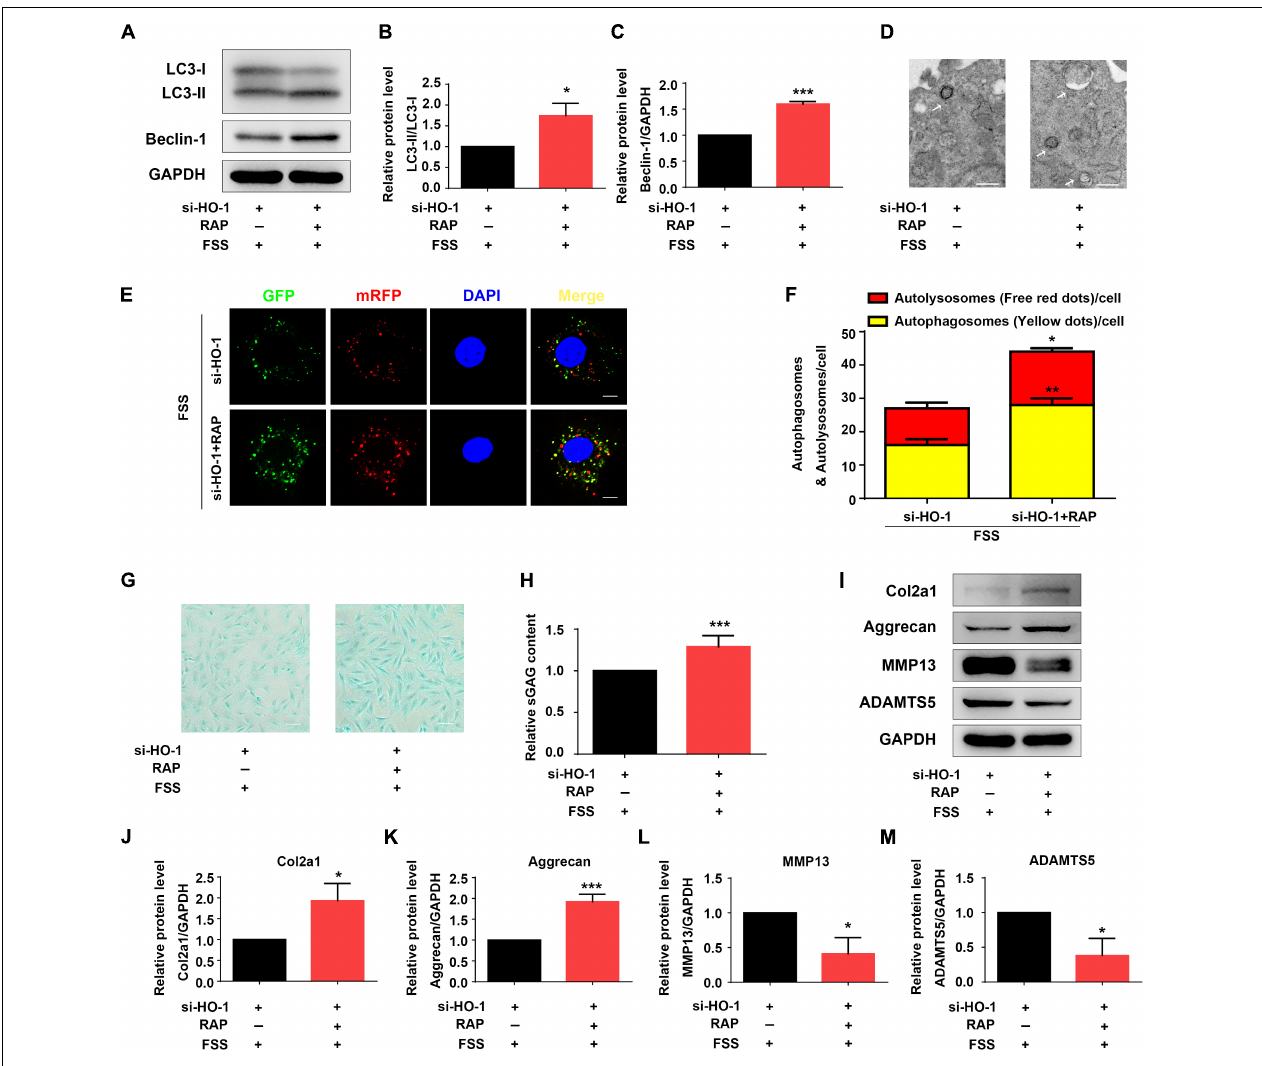
FIGURE 4 | Rapamycin regulates autophagy and ECM in NP cells. (A–C) Western blotting. NP cells were first transfected with HO-1 siRNA and treated with autophagy activator rapamycin (RAP, 500 nM) for 12 h. Cells were then treated with 12 dyne/cm 2 FSS for 2 h, followed by western blotting for expression of the indicated proteins. Quantification of LC3-II/LC3-I ratio and Beclin-1 from three independent experiments (B,C) . (D) Transmission Electron Microscopy (TEM). NP cells were treated as in panel (A) . TEM images are shown. The arrows indicate double-membrane autophagosomes and autolysosomes. Bar, 500 nm. (E,F) Measurements of autophagosomes and autolysosomes. NP cells were transduced with lentivirus expressing a tandem mRFP-GFP-LC3 construct and treated as in panel (A) . Fluorescence images were obtained. Bar, 5 µ m. Quantification of autophagosomes (yellow dots) and autolysosomes (free red dots) from three independent experiments (F) . (G,H) sGAG content. NP cells were treated as in panel (A) , followed by alcian blue staining (G) and Blyscan Sulfated Glycosaminoglycan Assay (H) . Bar, 100 µ m. (I–M) Western blotting. NP cells were treated as in panel (A) , followed by western blotting for expression of the indicated proteins (I) . Quantification of Col2a1, aggrecan, MMP13 and ADAMTS5 from three independent experiments (J–M) . Results are expressed as mean ± standard deviation (s.d.). * P < 0.05 and *** P < 0.001 vs. FSS + HO-1-siRNA group.